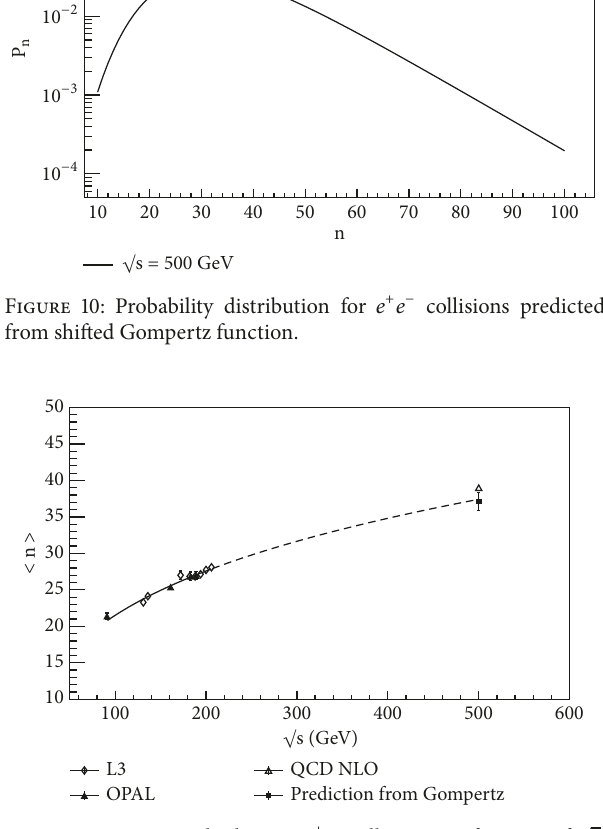
Figure 11: Averagemultiplicity in 𝑒 + 𝑒 − collisions as a functionof √𝑠 . The fitted curve represents Fermi-Landau